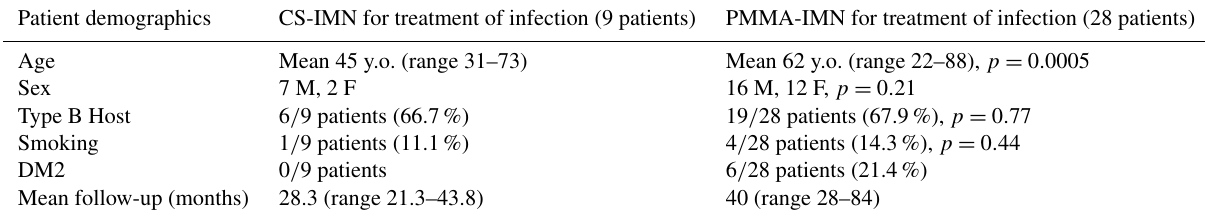
Table 1. Patient demographics in the active infection treatment groups.